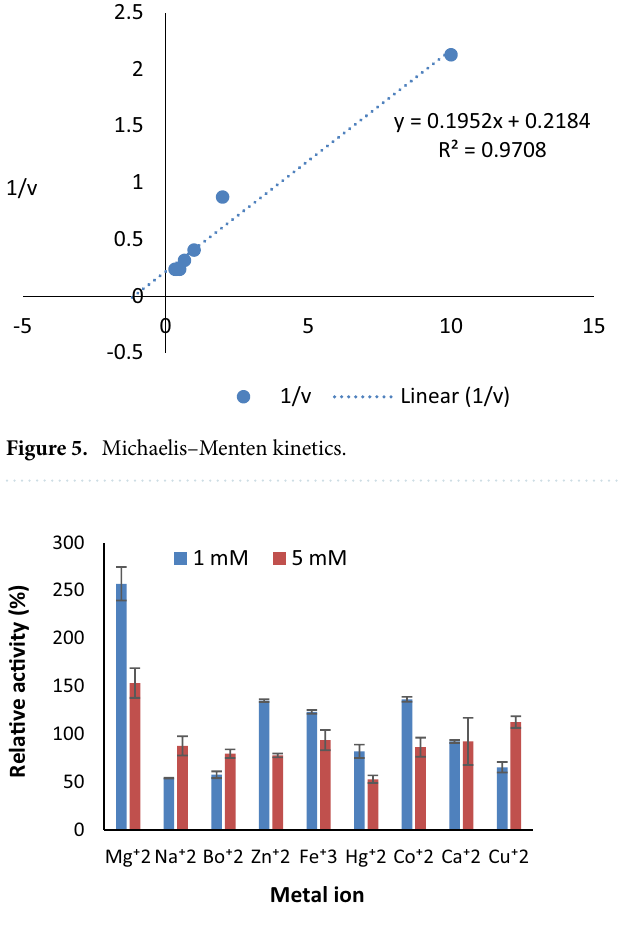
Figure 6. Effect of various metal ions at 1 mM and 5 mM concentrations on pectate lyase activity of Paenibacillus lactis